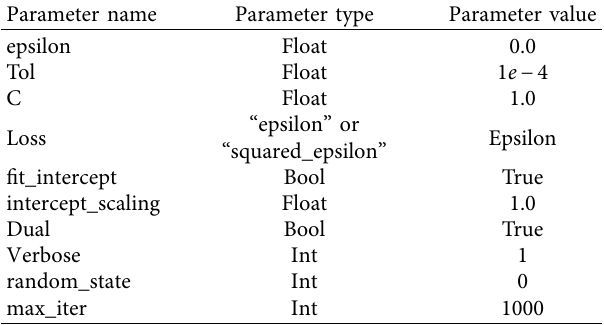
Table 2: The value of eight parameters of SVR.